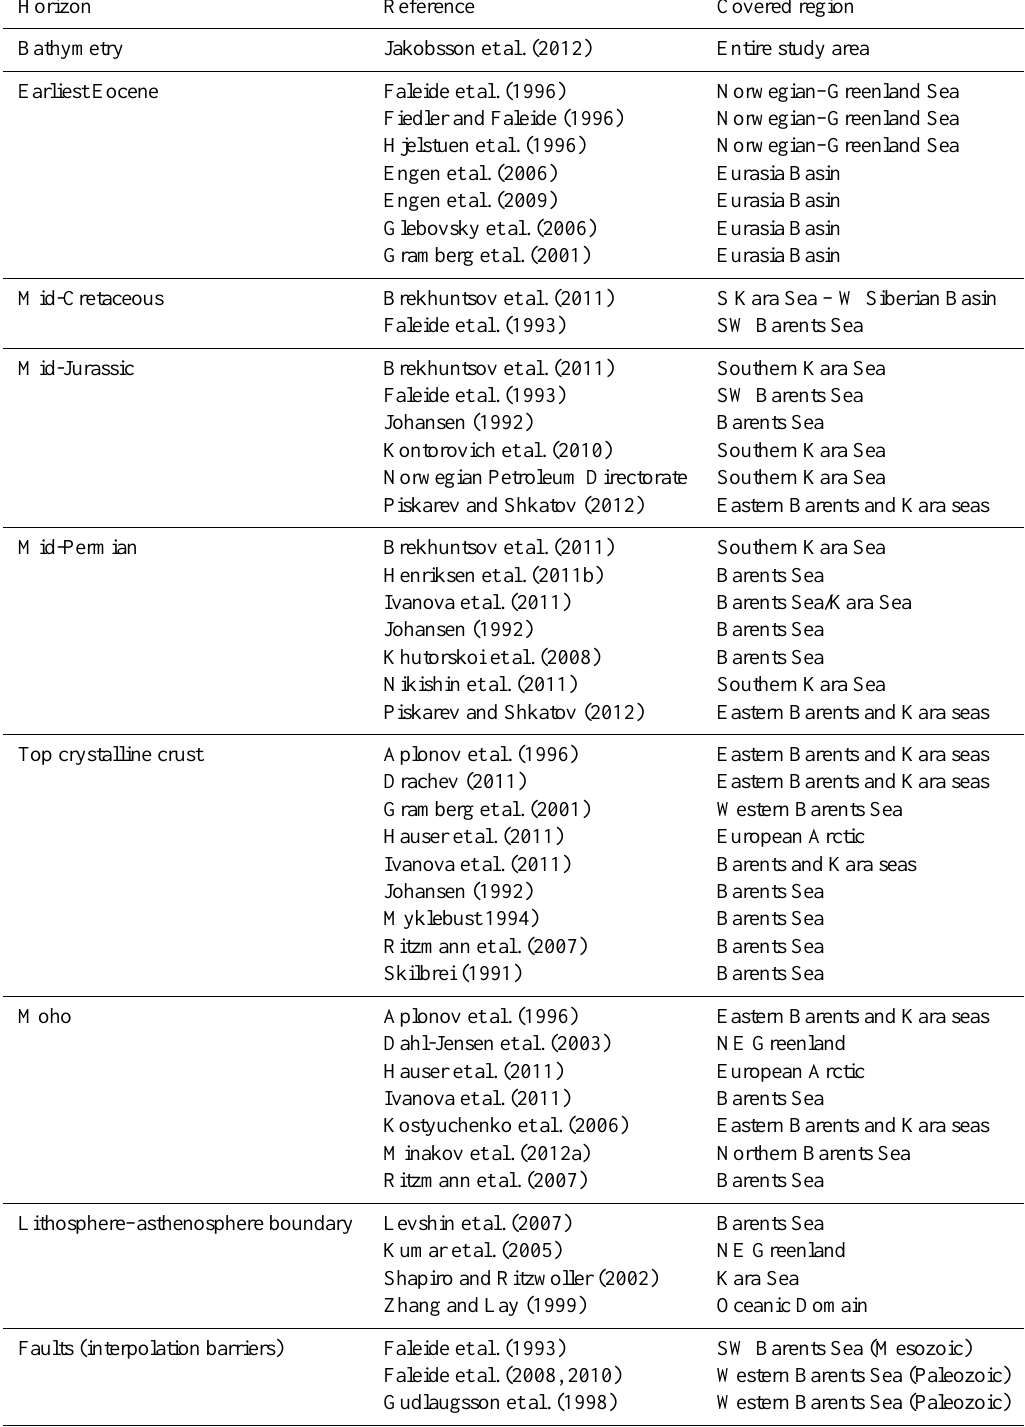
Table 1. References and coverage for the different horizons of the 3-D structural